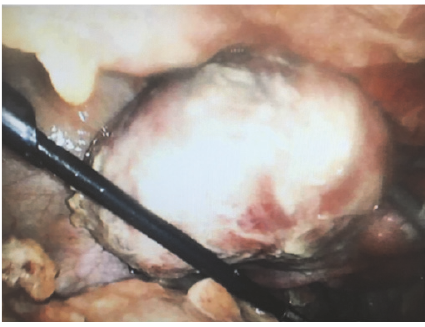
Figure 2: The left broad ligament pyomyoma. Purulent material is visible along the abdominal wall and bowel.